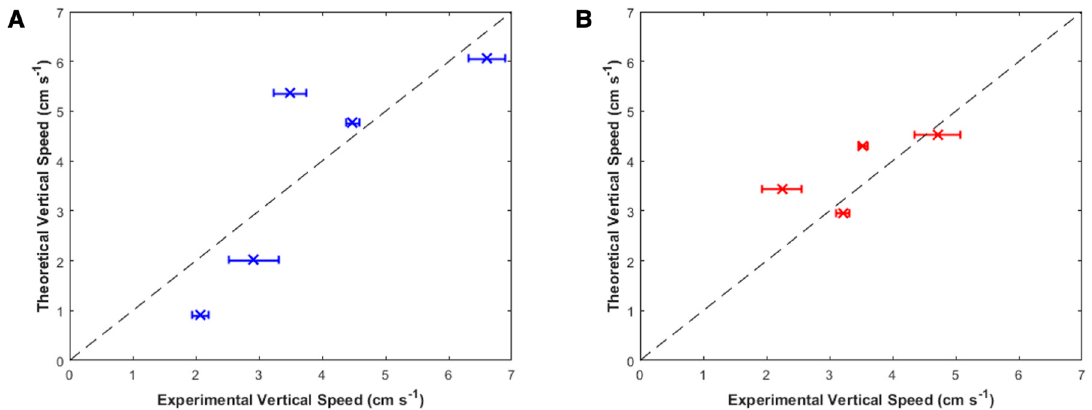
Figure 8. Theoretical versus experimental vertical swimming speeds. Theoretical vertical speeds from the hydrodynamic model versus the measured experimental vertical speeds for each individual jellyfish ( A ) blue using the input parameters delineated in the top row of Table 2 and ( B ) red using the input parameters delineated in the bottom row of Table 2. Inputs were obtained using morphological and time-dependent parameters for each jellyfish. The line of unity is plotted as black dashed lines.